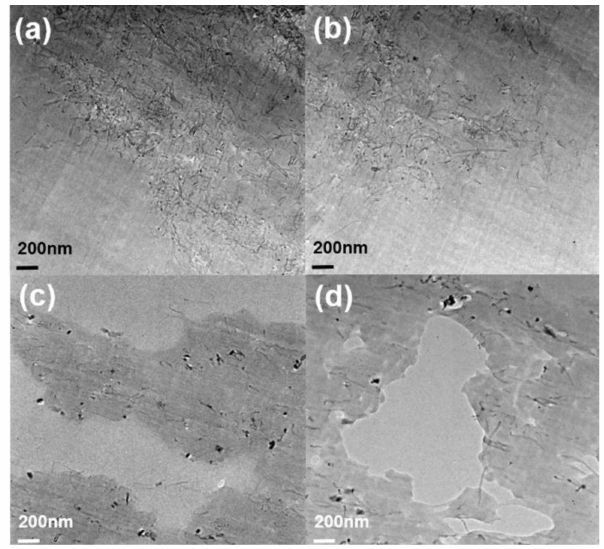
Figure 5. TEM image of PMMA / PS / CNT(90 / 10 / 0.5wt%) composites: ( a , b ) PMMA / PS / CNT and ( c , d ) PMMA / PS / PMMA– g